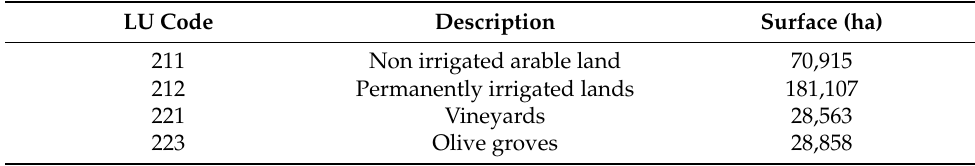
Table 2. Main agricultural land use classes of the Capitanata plain and their